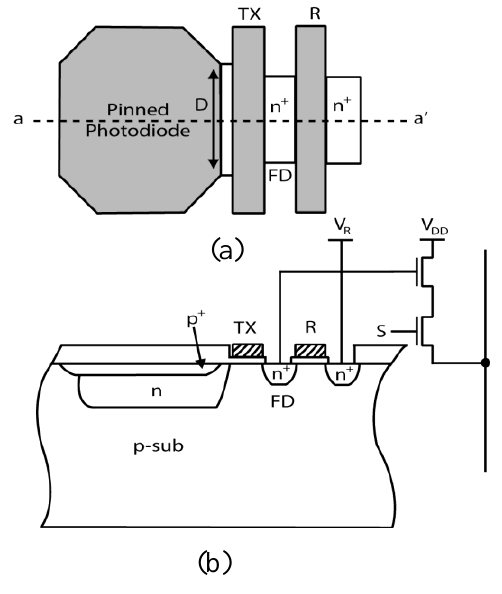
Figure 1. (a) Simplified layout and (b) cross section at line aa’, of the pixel.